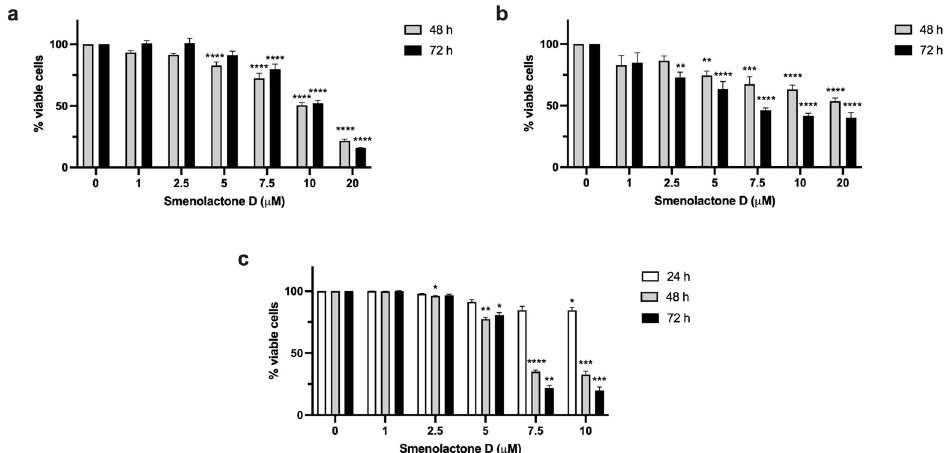
Figure 4. Smenolactone D is cytotoxic in all tested cell lines in a time- or concentration-dependent manner. Percentage (%) of viable A-431 ( a ) MCF-7 ( b ) and Jurkat ( c ) cells after treatment with increasing concentrations of smenolactone D for 48 or 72 h. * p < 0.05, ** p < 0.01, *** p < 0.001; **** p < 0.0001 compared to untreated cells. Table 1. IC 50 values calculated from dose–response curves of Jurkat, A-431, and MCF-7 cells treated with smenolactone D for 24, 48, or 72 h.